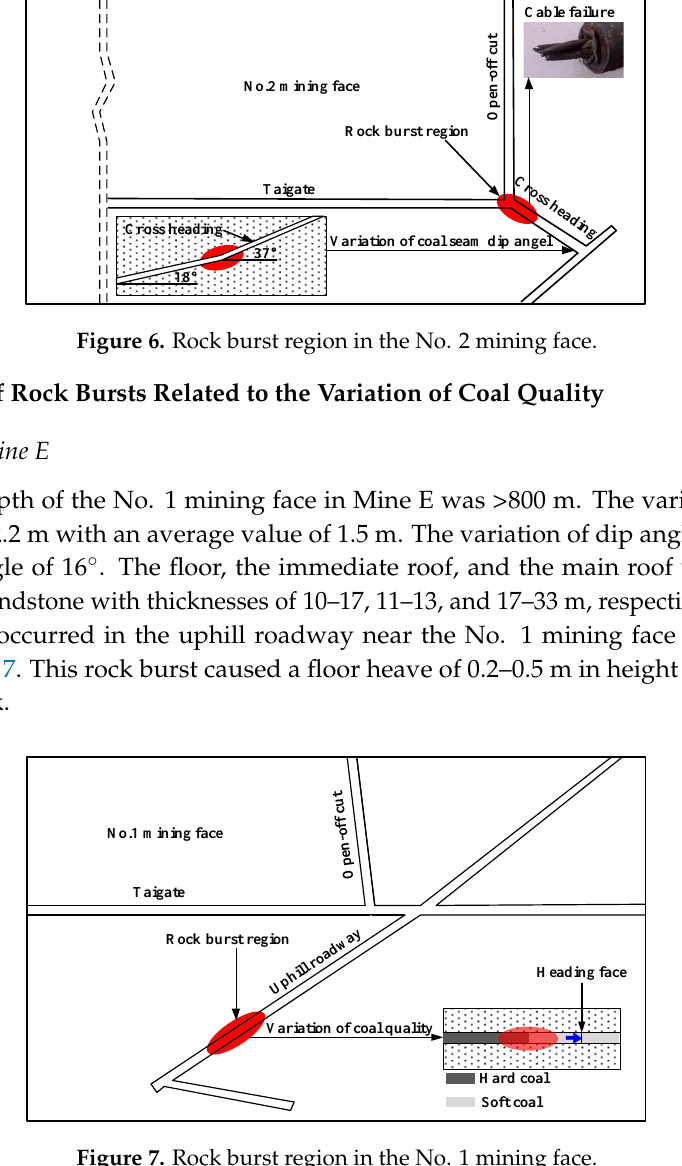
Figure 7. Rock burst region in the No. 1 mining face.